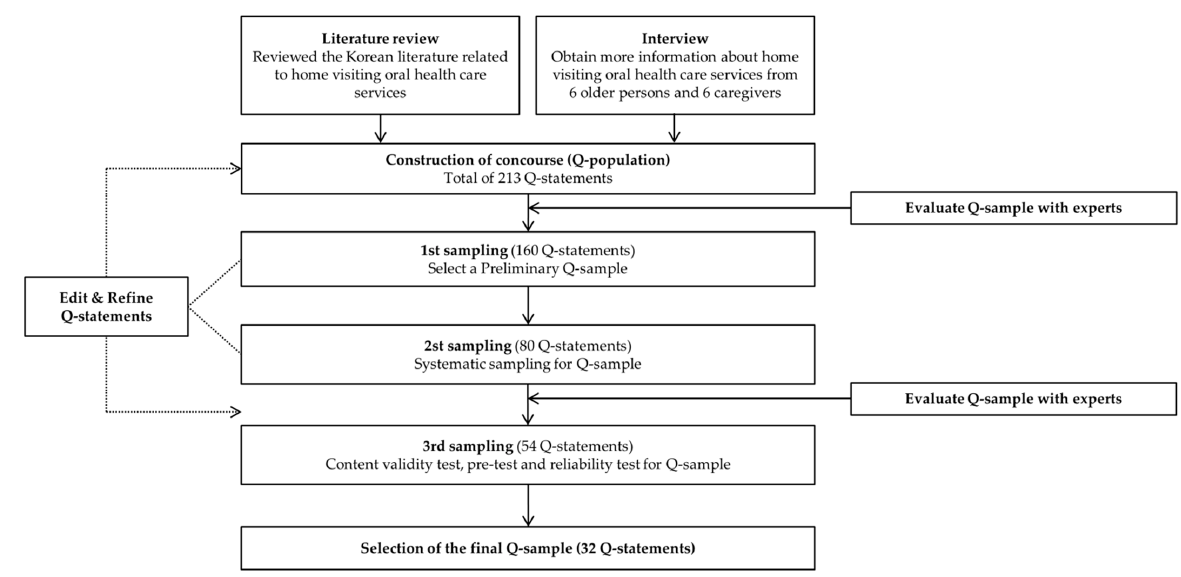
Figure 1. Flowchart of Q-sample construction.